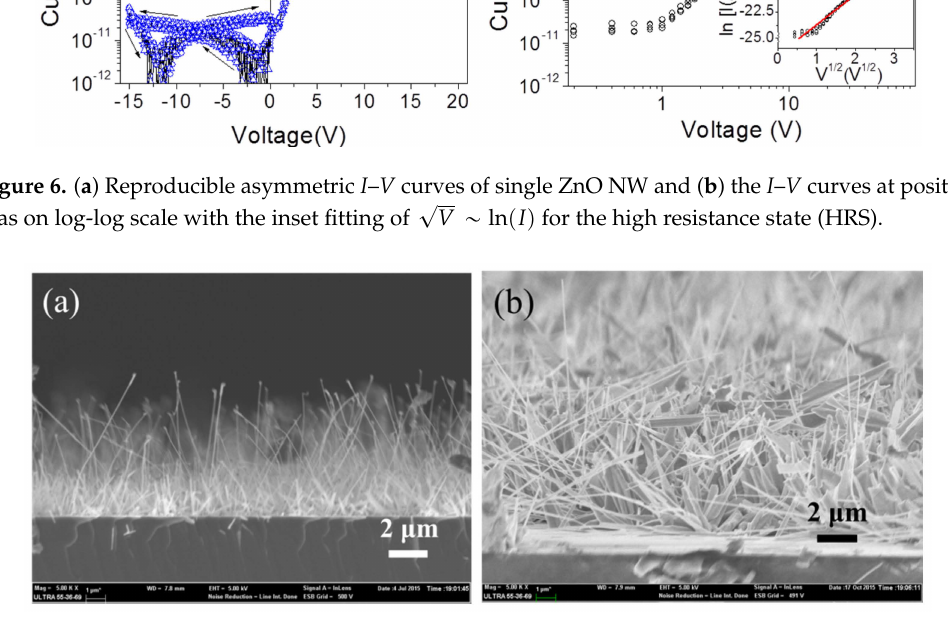
Figure 7. Cross-sectional scanning electron microscope (SEM) images of the ZnO NWs on the silicon substrates with gold thicknesses of ( a ) ~2 nm and ( b ) ~4